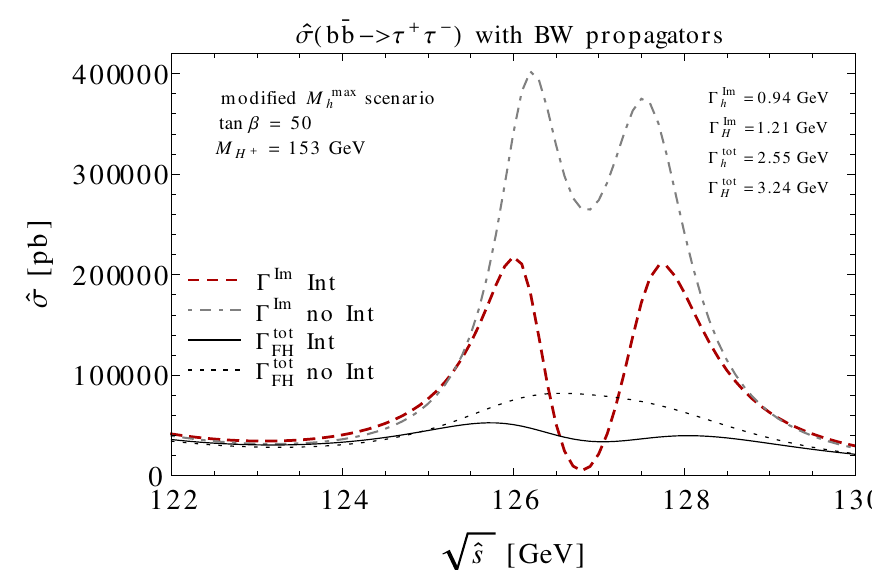
^ Figure 13 . E(cid:11)ect of the total width as an input for Breit-Wigner propagators: the partonic cross section ^ (cid:27) ( bb ! (cid:28) + (cid:28) (cid:0) ) in the same modi(cid:12)ed M max -scenario as in (cid:12)gure 11 with tan (cid:12) = 50 and h M = 153 GeV. The Breit-Wigner propagators with the total widths from the imaginary part of H + the complex pole including (red, dashed) and excluding (grey, dash-dotted) the interference term (as in (cid:12)gure 11) are compared with the Breit-Wigner propagators where the total widths are obtained from FeynHiggs . The corresponding results are shown including (black, solid) and excluding (black, dotted) the interference